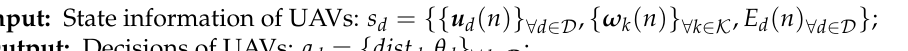
Algorithm 1 Memory-Based Reading and Writing